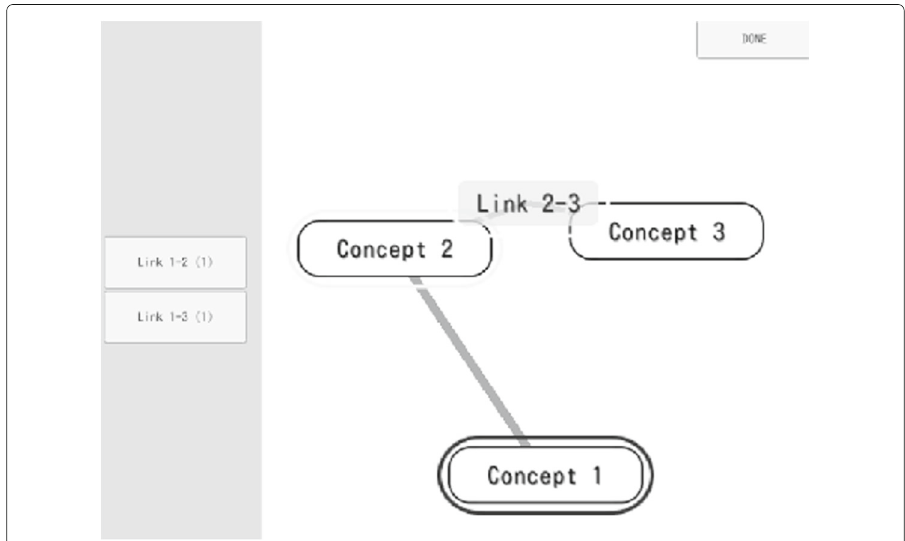
Fig. 2 The Airmap